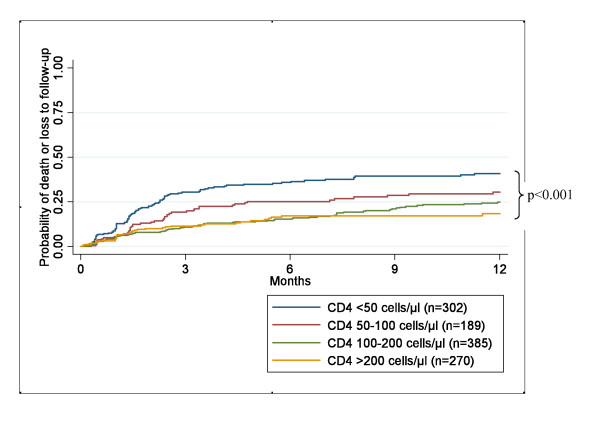
Time to death or loss to follow-up during the first year after starting cART according to the baseline CD4 cell count cells/μl.